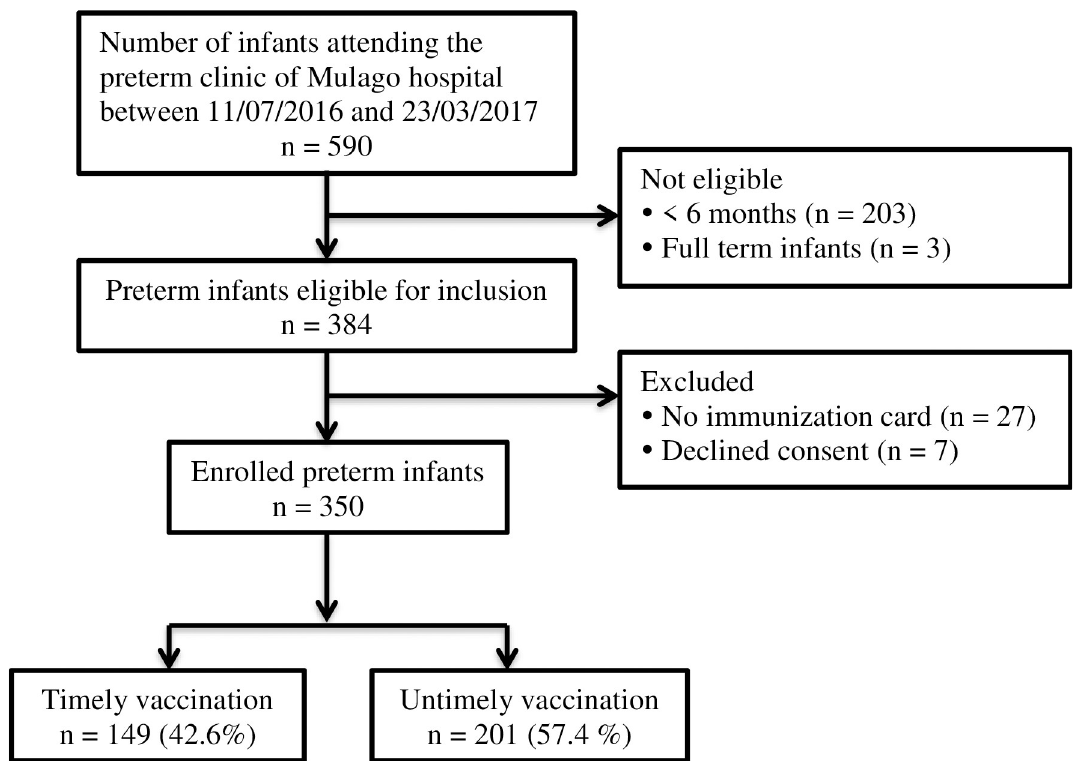
Fig 1. Flow diagram of the study population with inclusion and exclusion